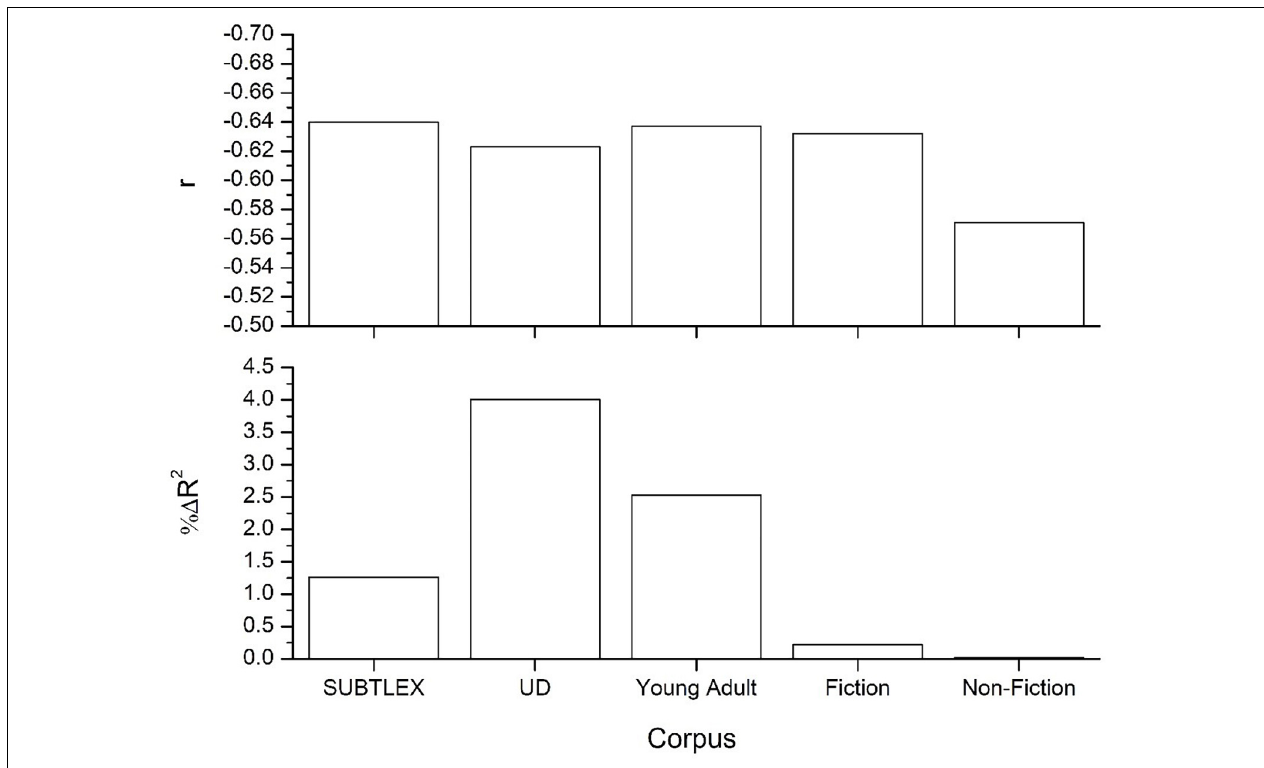
FIGURE 1 | Top panel displays the correlation between word frequencies from the various corpora to lexical decision data from the English lexicon project (Balota et al., 2007), while the bottom panel displays the amount of unique variance each word frequency count accounts for. All correlations significant at the p < 0.001 level, while the R 2 -change values were all significant at p < 0.001 except for the frequency values from the non-fiction